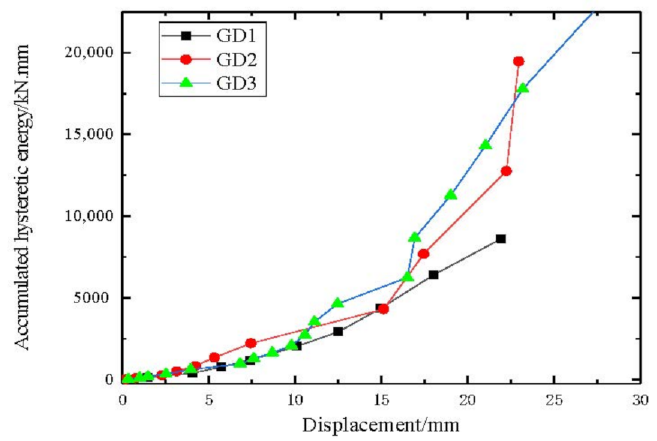
Figure 14. Comparison of energy dissipation coefficients of